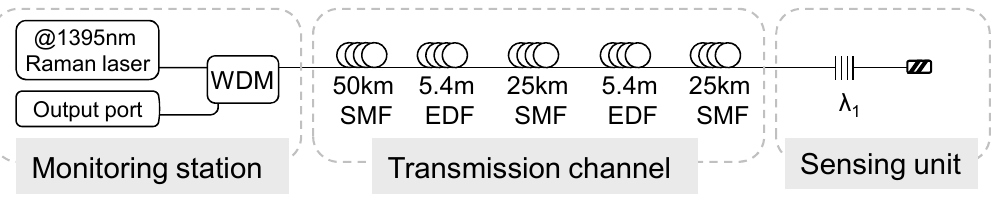
Figure 7. Experimental set-up for the FBG sensor system. Adapted from